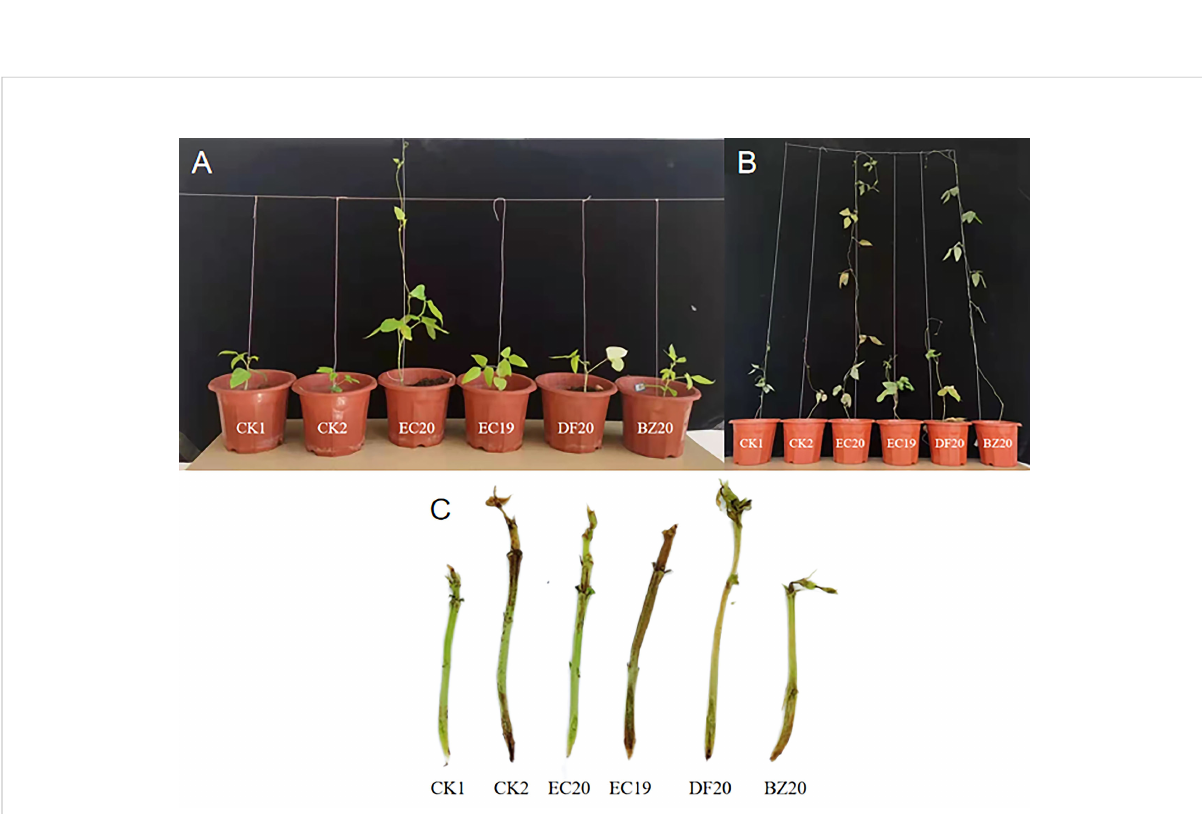
FIGURE 7 Effect of biofertilizer against cowpea blight on different plant stages and stem length. (A) Seedling stage (B) Adult stage, and (C) Stem